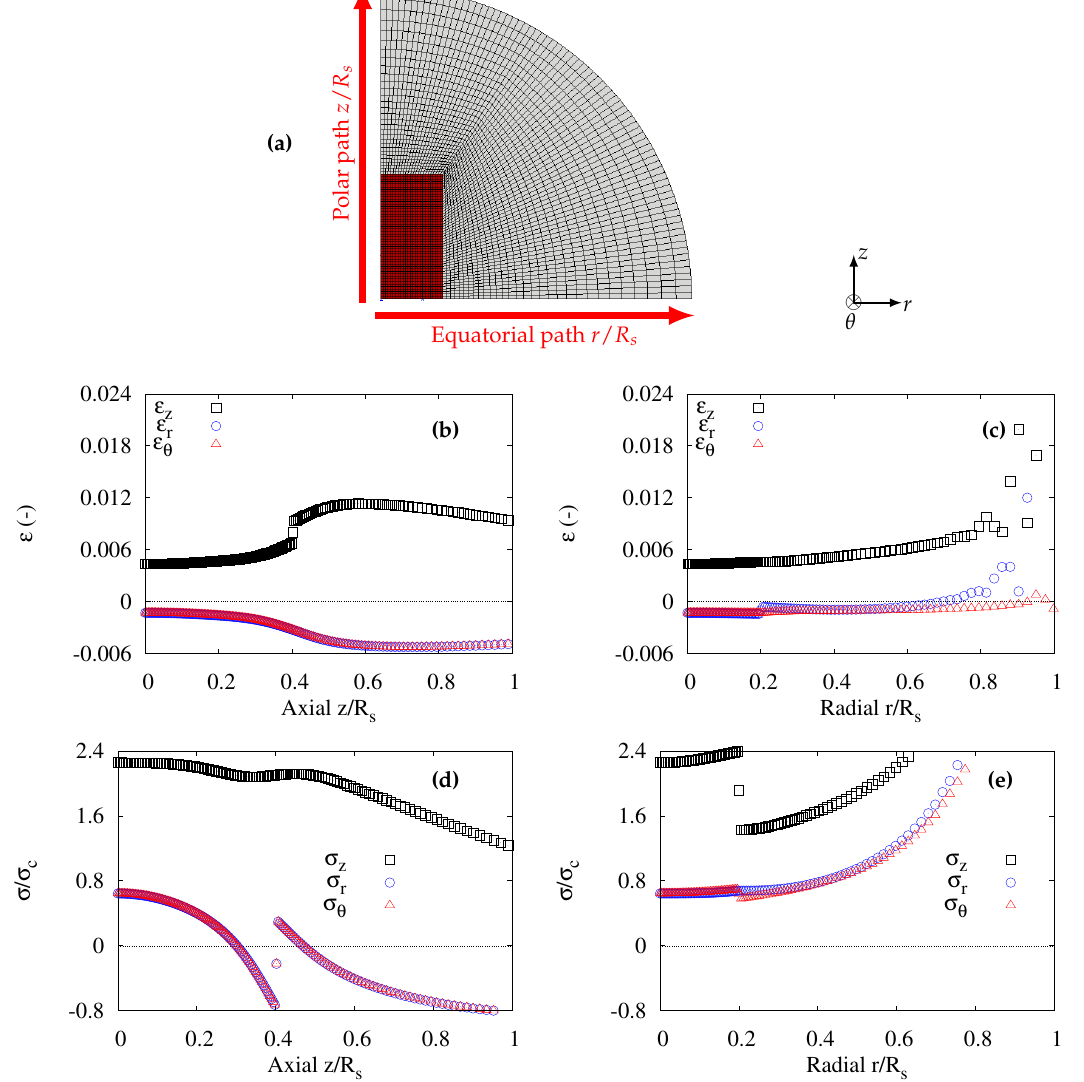
Figure 3. Spherulite with stiff nucleus inside: ( a ) mesh and coordinates; ( b ) strains along the axial path; ( c ) strains along the radial path; ( d ) stresses along the axial path; ( e ) stresses along the radial